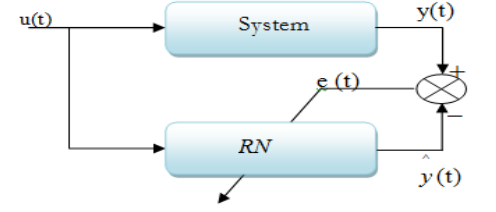
Fig 1. ANFIS controller proposed The error equation is used by an appropriate learning algorithm to